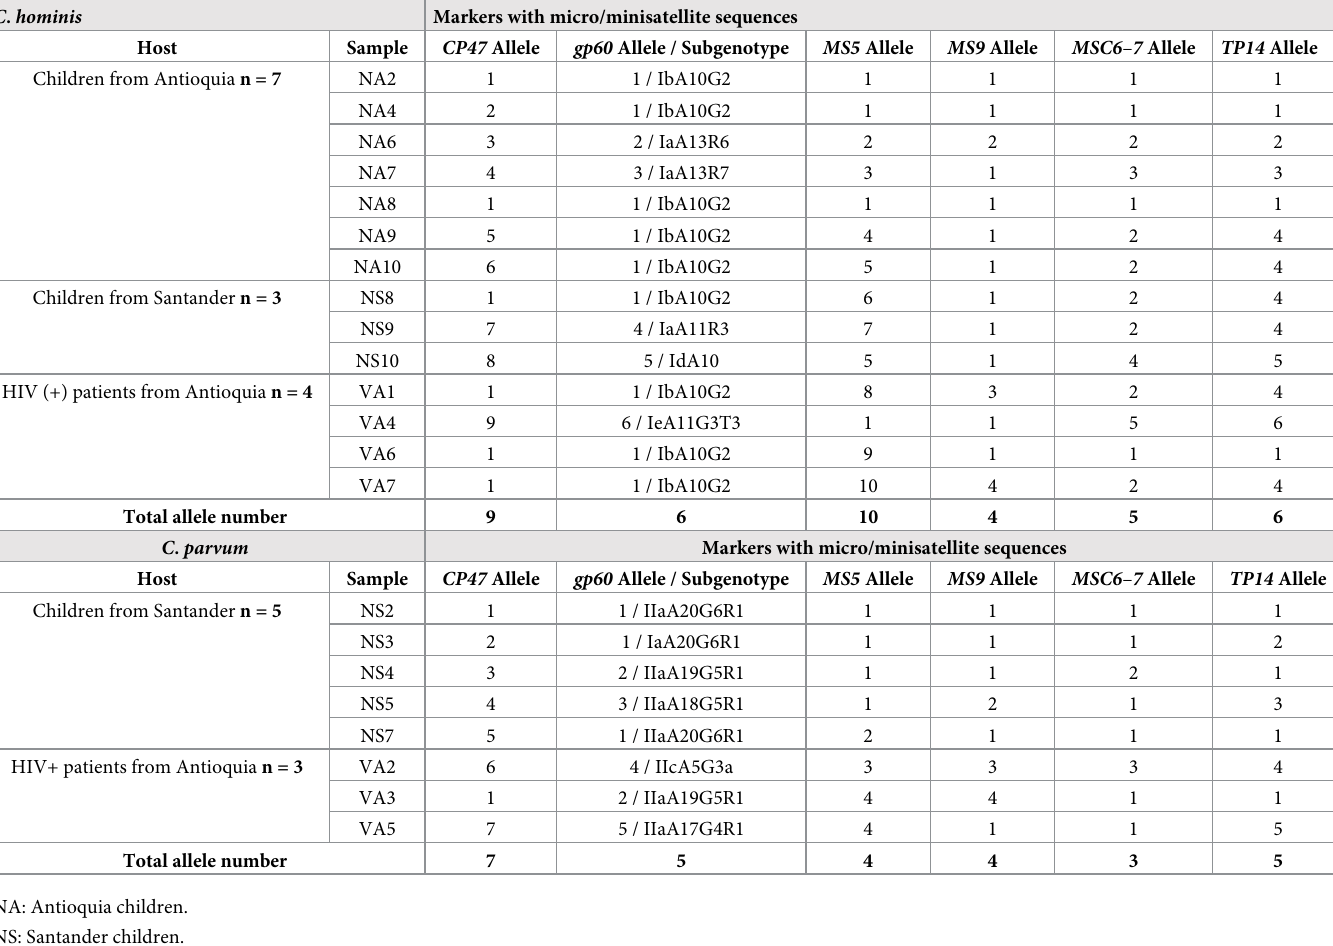
Table 2. Allele identification for CP47 , gp60 , MS5 , MS9 , MSC6 – 7 , and TP14 in C . hominis and C . parvum positive